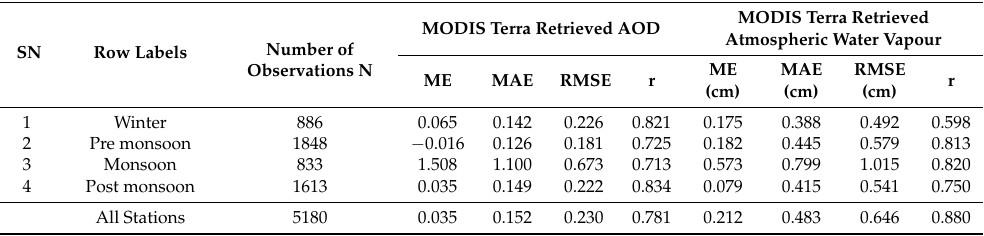
Table 8. Evaluation of MODIS Terra derived AOD and atmospheric water vapour against AERONET measured AOD and atmospheric water vapour in four seasons in the IGP. MODIS Terra Retrieved Atmospheric MODIS Terra Retrieved AOD